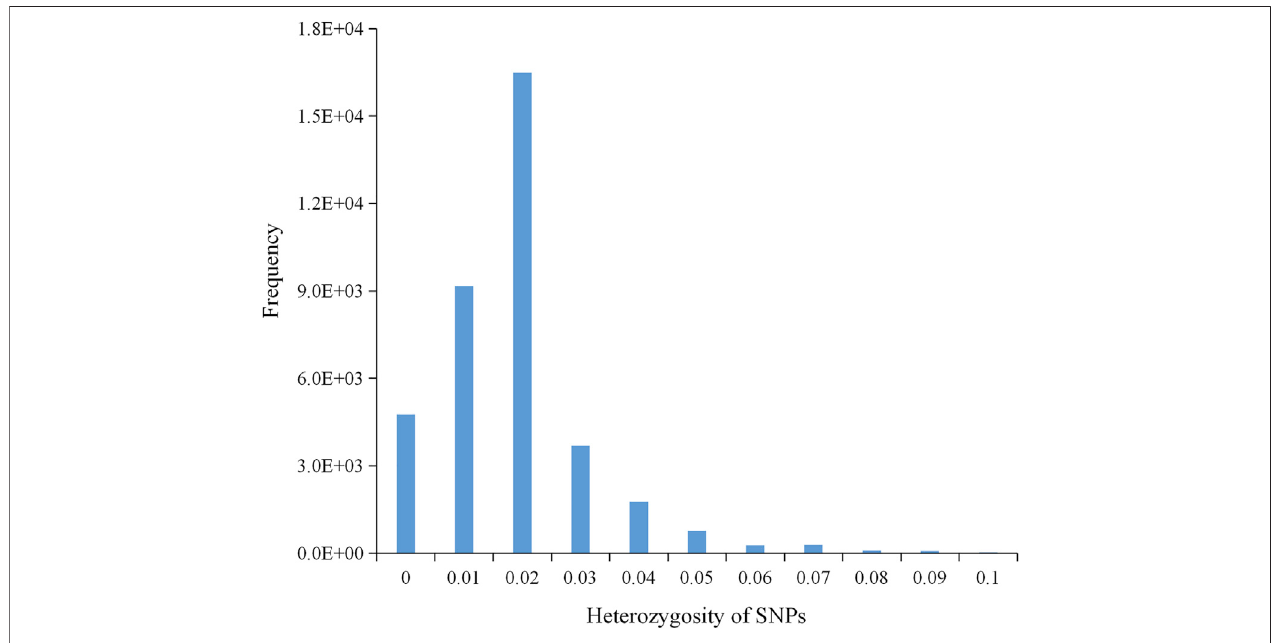
FIGURE 1 | A histogram showing the normal distribution of heterozygosity of 37,929 SNPs.